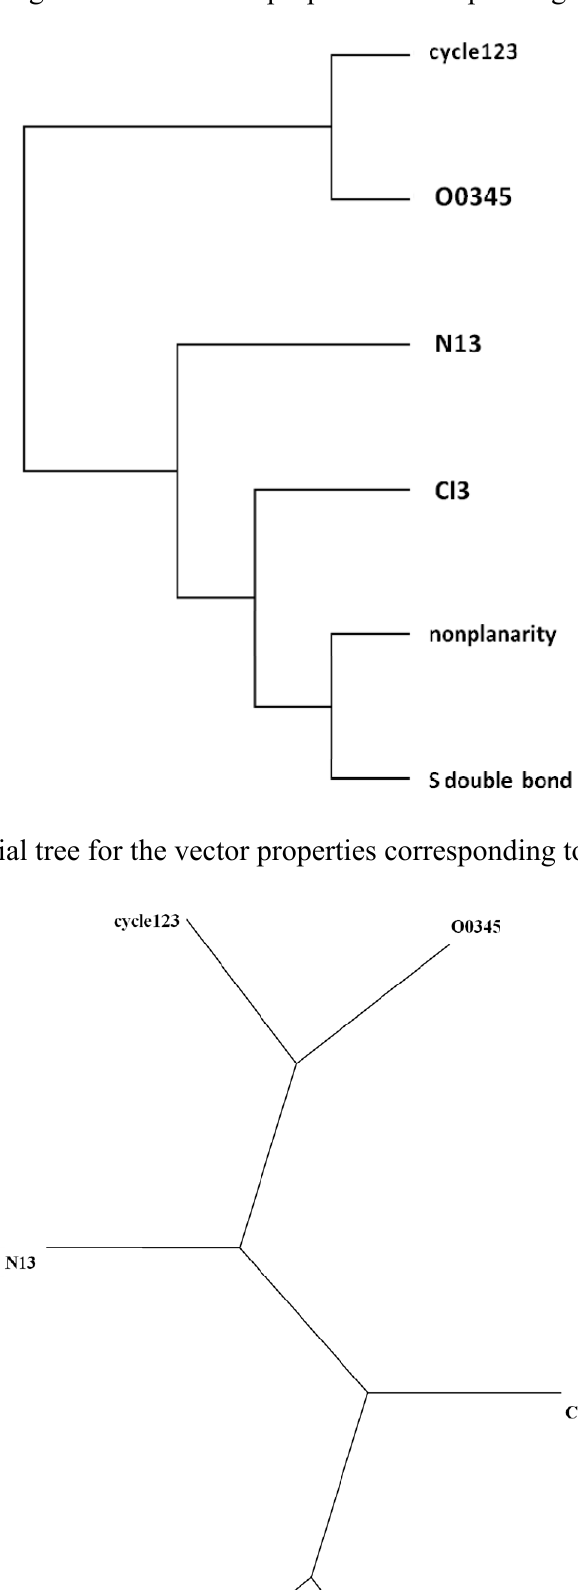
Figure 7. Dendrogram for the vector properties corresponding to the pesticides.